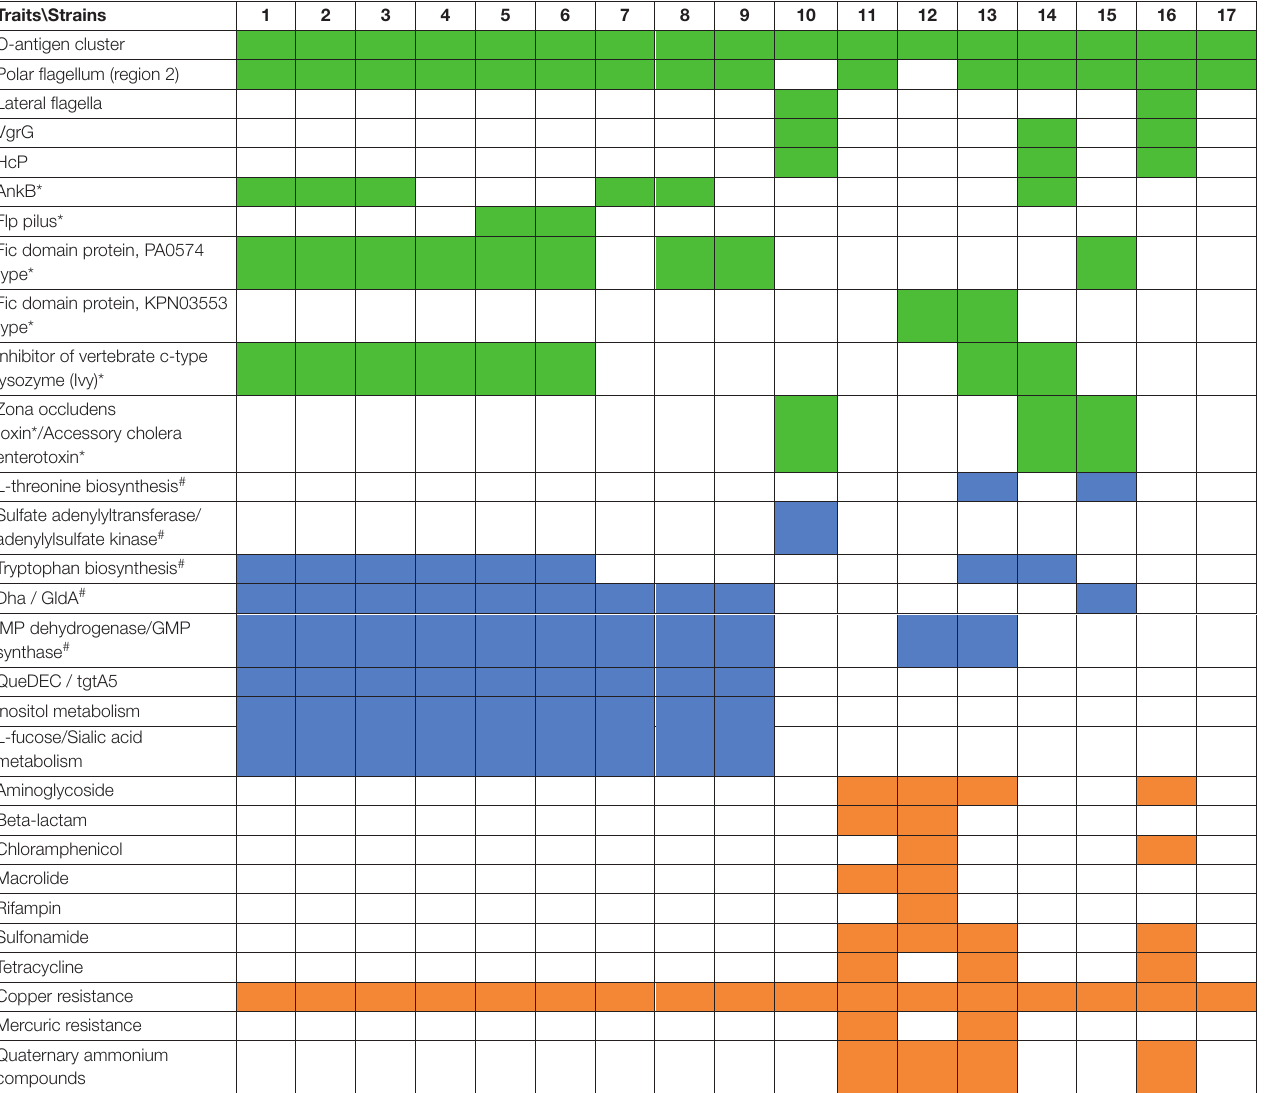
TABLE 3 | Main traits encoded in predicted genomic islands